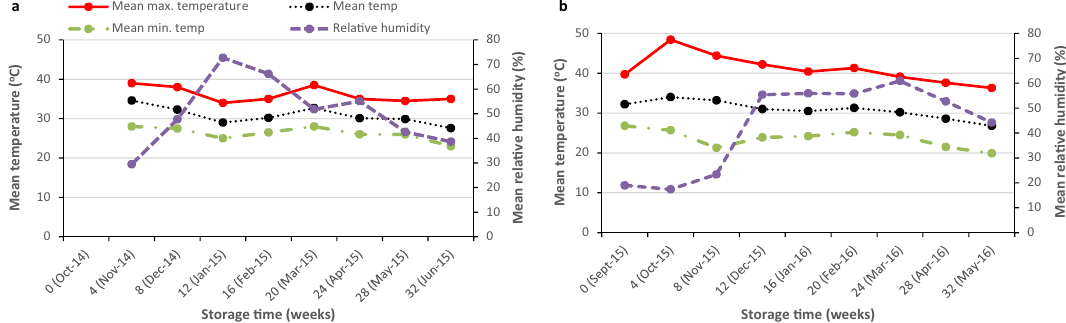
Figure 5. Ambient temperature and relative humidity conditions within the storage rooms in Mbire district, Zimbabwe during ( a ) the 2014/15 and ( b ) the 2015/16 storage